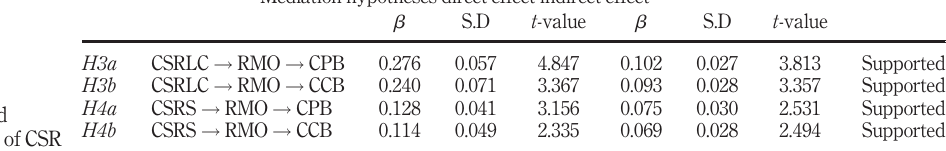
Figure 3. Mediation model: the relationship of corporate social responsibility (CSR) activities, customer value co- creation behavior and relationship marketing orientation